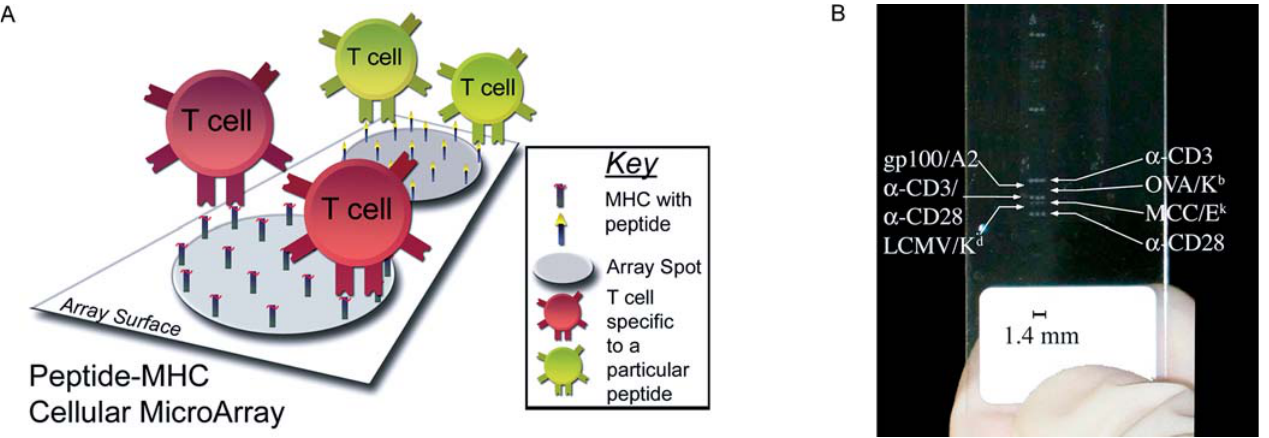
Figure 1. A Cellular Microarray (A) A schematic diagram illustrating T cell binding to its cognate peptide–MHC spot via peptide–MHC–TCR interactions (not drawn to scale). (B) Cells immobilized on the cellular microarray are immediately visible to inspection. When cell coverage exceeds approximately 20%